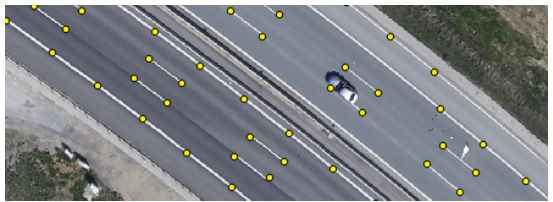
Figure 14. The reconstructed line-nodes on aerial image, in UTM 32N coordiate system.